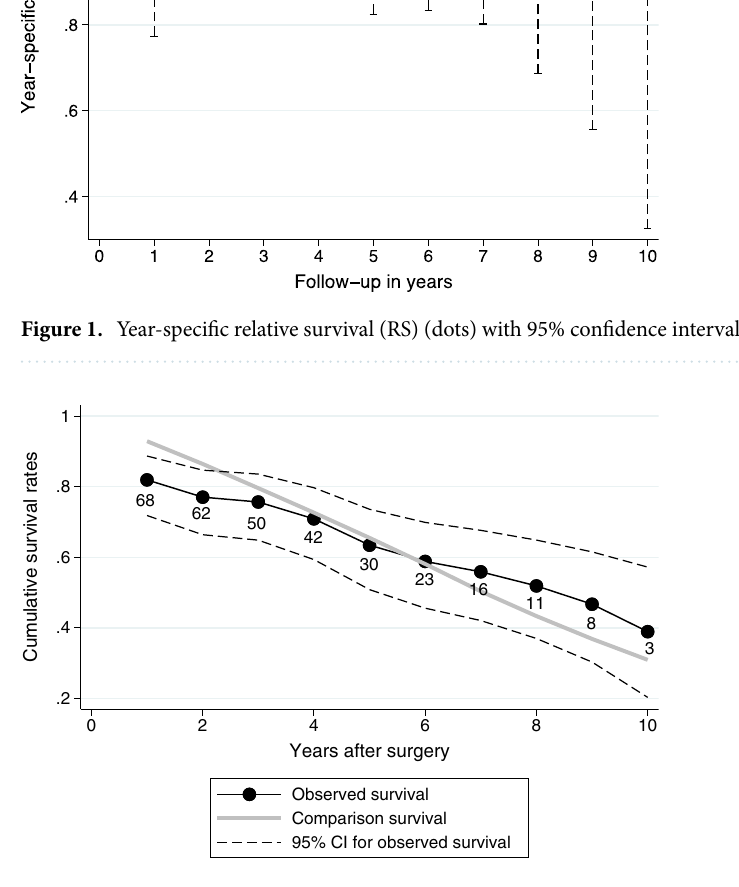
Figure 2. Cumulative survival rates of operated IM patients (black connected line) with 95% CIs (black dashed lines) and the age-, sex- and year-matched general Finnish population (grey solid line). Difference between solid lines depicts the relative survival, whereas marked values below the observed survival line (black connected line) describe the number of patients whose follow-up lasted at least until the yearly time